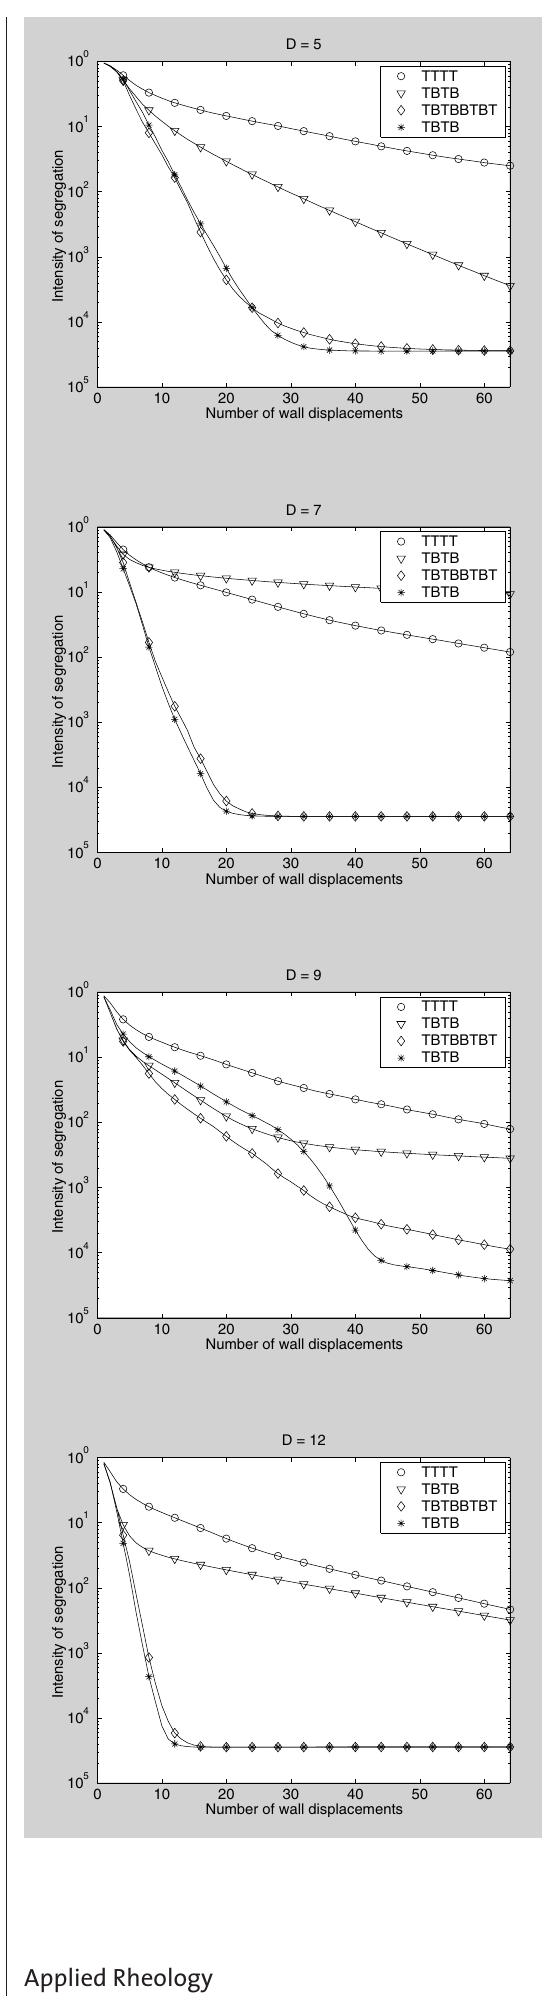
Figure 5: Comparison of different mixing